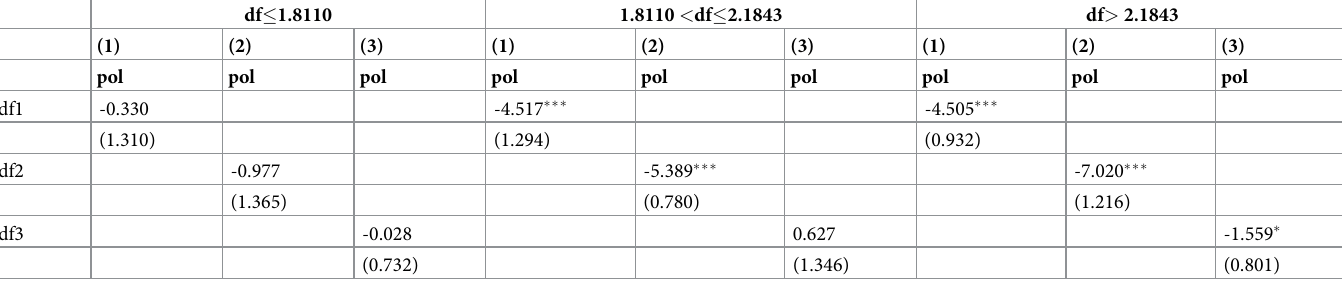
Table 10. Phased regression results of digital finance in different dimensions.